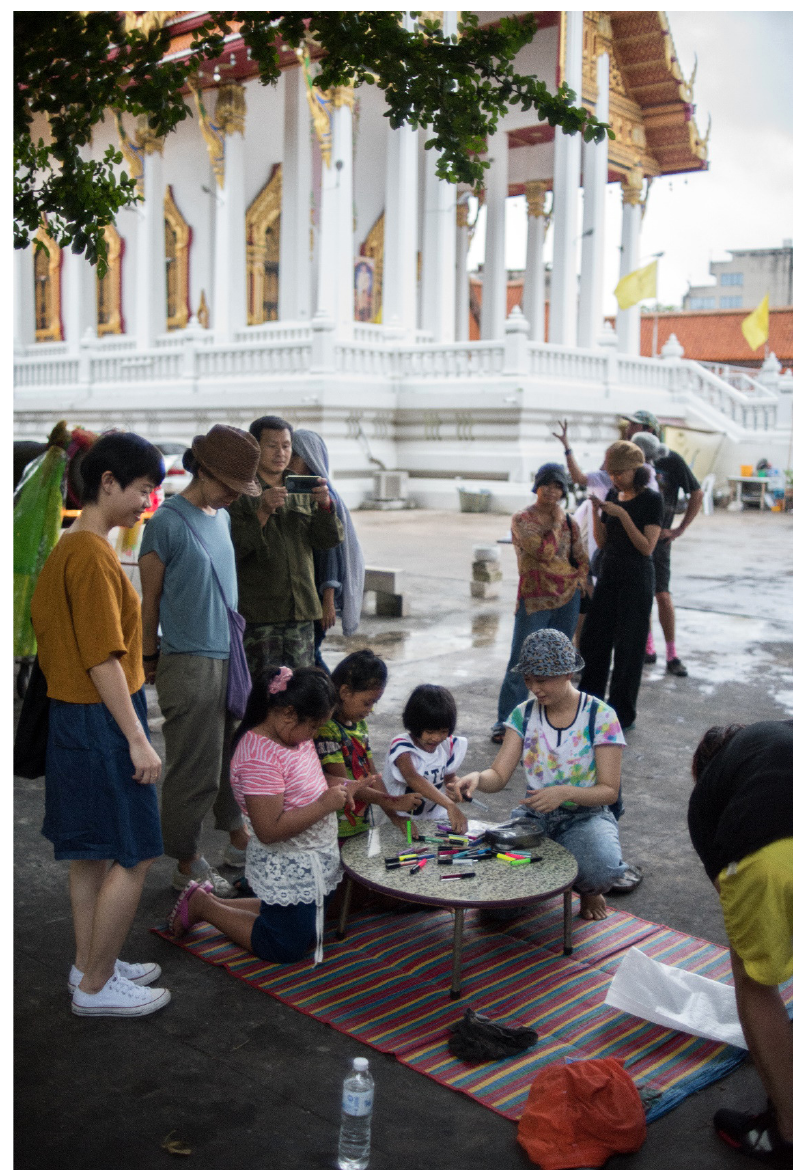
Figure 6. Tiger, Tiger parade and performance at Soonthorn Thammathan temple (Wat Khae Nang Loeng) in Nang Loeng, Bangkok (August 2018). Photo courtesy of Bangkok